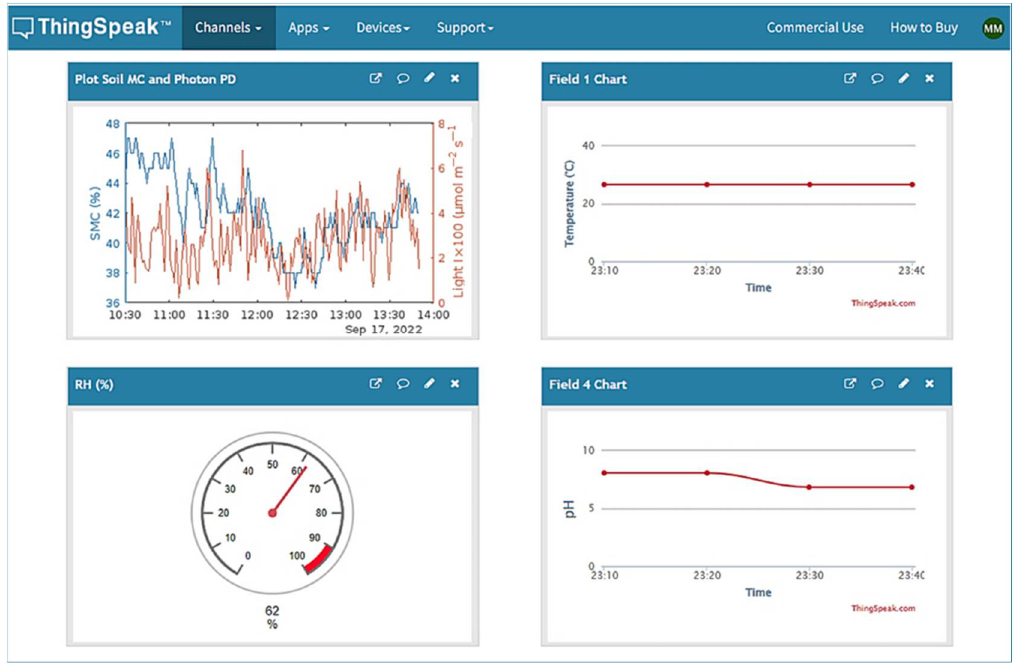
Figure 8. A screenshot of the received soil moisture content (SMC), light intensity (LightI), temperature, RH, and soil pH via the ThingSpeak platform [71].